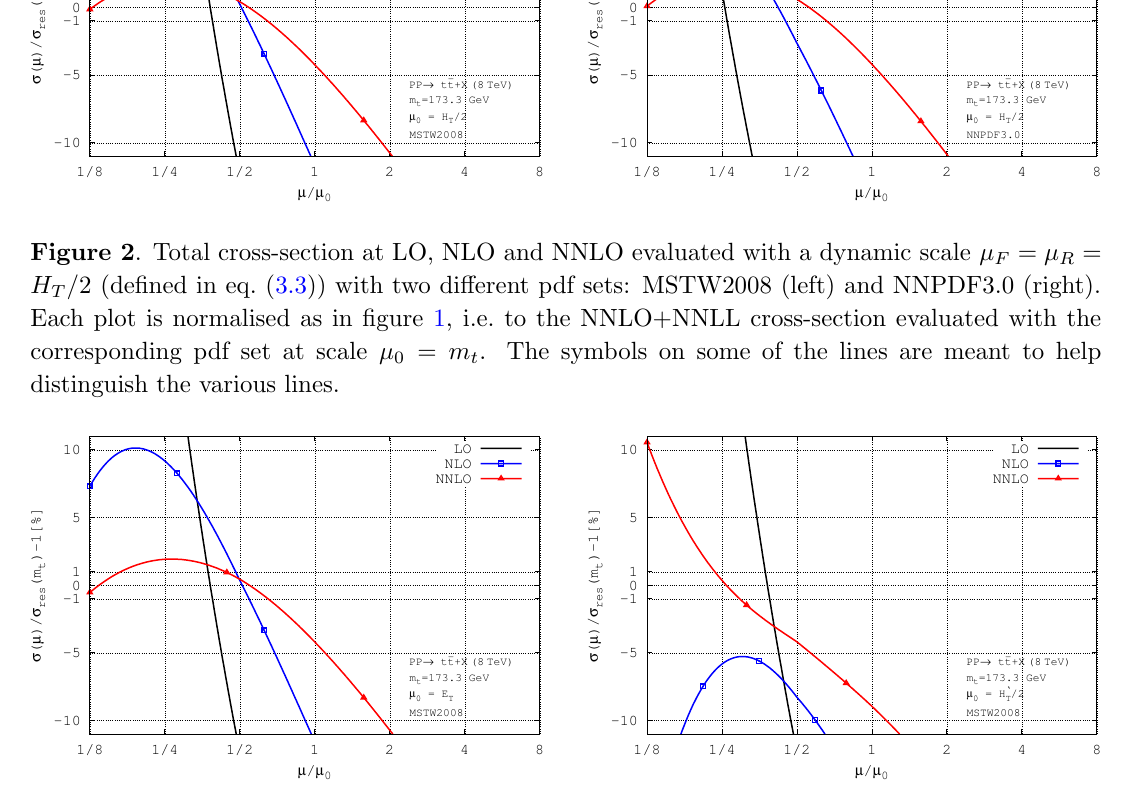
(3.4) (right). Both use pdf set T